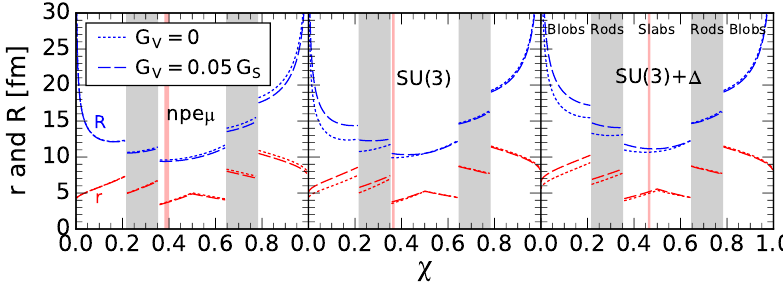
Figure 3. Radius of the rare phase structure r and Wigner–Seitz cell R in the quark–hadron mixed phase for the DD2 parametrization [7]. See Figure 2 for additional details. Similar figures for the SWL, GM1L, and ME2 parametrizations can be found in Reference [7].